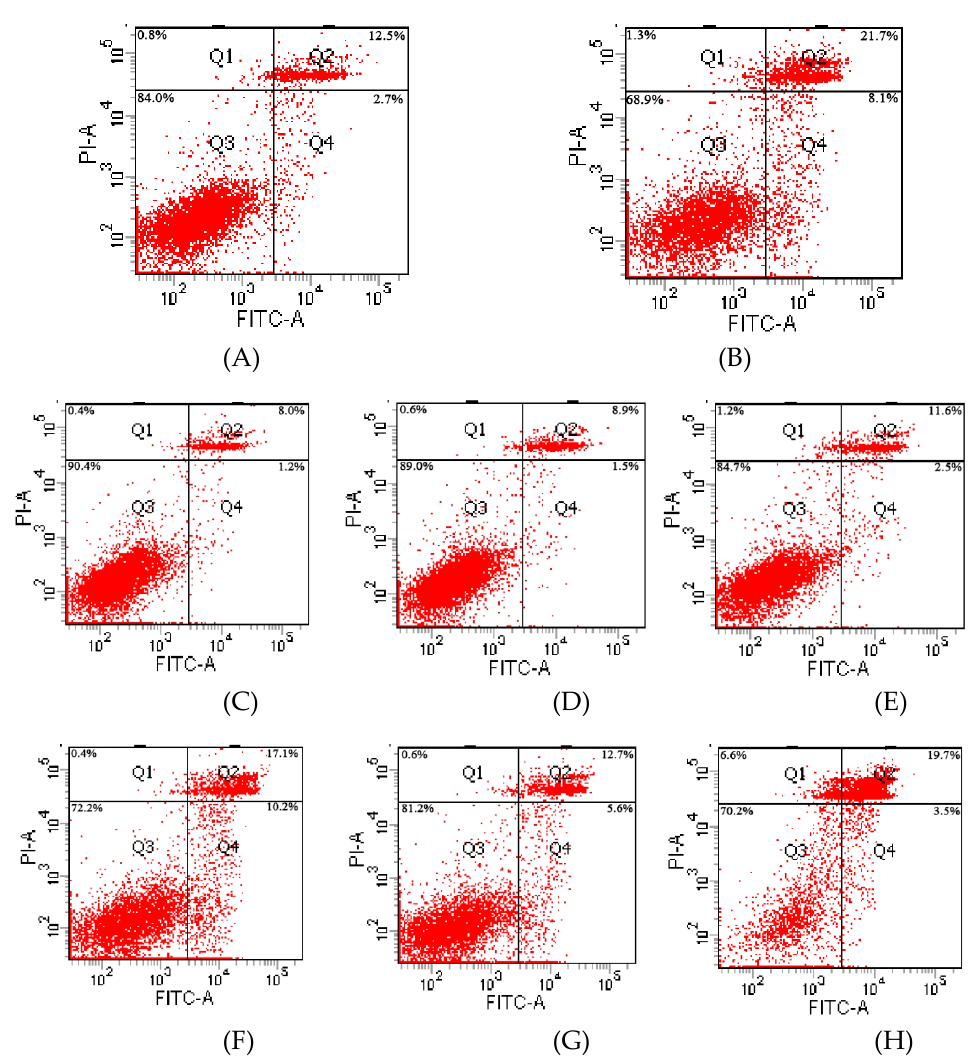
Figure 6. Scatter plot of cell cytometry. ( A ) Control group; ( B ) Cd group; ( C ) SFN2.5 group; ( D ) SFN5